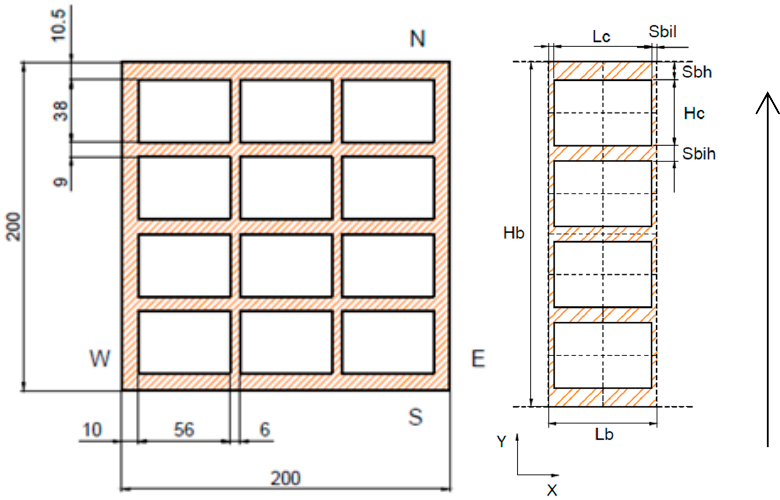
Figure 1. Sketch of the masonry unit and simulation domain; dimensions in mm; heat flux direction shown by the arrow.